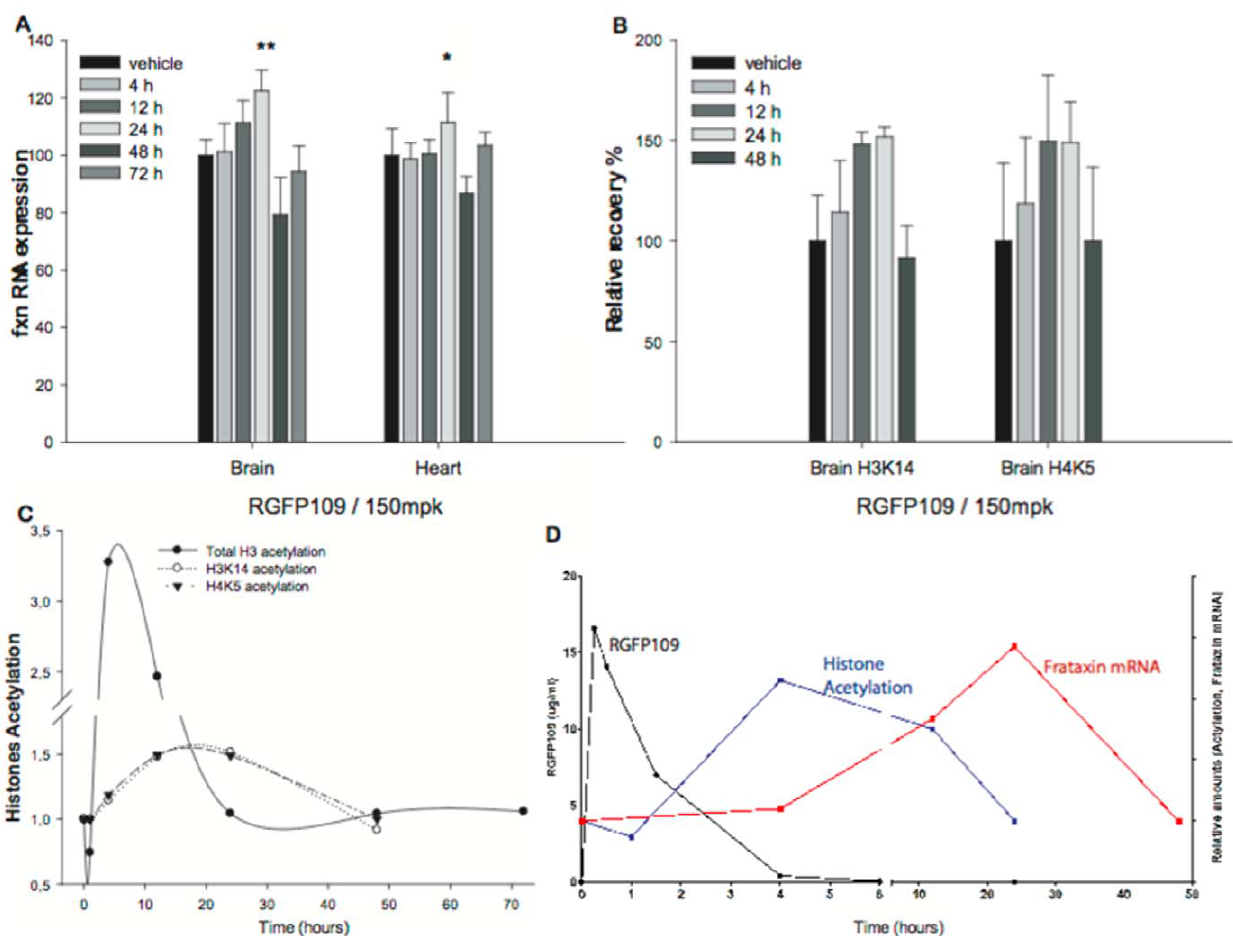
Figure 4. Time course for drug exposure, frataxin mRNA expression, and histone acetylation changes in the brain and heart of KIKI mice. A. Fxn mRNA measurement by quantitative real-time RT-PCR in brain and heart of KIKI mice dosed subcutaneously with 109 at 150 mg/kg (n=26) or vehicle (n=13). Treated mice were sacrificed at one of the mentioned time points: 4, 12, 24, 48 or 72 h. Vehicle treated mice were sacrificed 24 hours after injection. Fxn mRNA levels were relative to RER1 and beta-2 microglobulin (b2M). The Fxn level in vehicle injected KIKI of each tissue was set to 100. All quantifications were done in triplicate and bars indicate s.d. (** p , 0.001; * p , 0.05). B. Levels of H4K5 and H3K14 acetylation in KIKI mice brain treated with one subcutaneous injection of 150 mg/kg of 109 compared to vehicle-treated KIKI littermates, after 4, 12, 24 or 48 hours (n=4 for each shown time point). We performed ChIP experiments with antibodies for murine histones H3 and H4 carrying each modification. Primer pairs corresponded to the first intron of the mouse frataxin gene just upstream of the point of insertion of the GAA repeat in KIKI mice. Relative recovery, determined as previously (Fig. 3B) is set to 100 for each residue. Each immunoprecipitation was quantified in triplicate. Error bars are s.e.m. C. Brains from wild-type mice for total histone H3 acetylation and from KIKI mice for specific residues acetylation, injected with either vehicle or with 150 mg/kg of 109 , were harvested after a period of 1, 4, 12, 24, 48 or 72 hours (n=5 per condition) and subjected to western blot with total or acetylated histones H3 antibodies for WT samples or to chromatin immunoprecipitation for KIKI samples. Ratio of acetylated H3 over total H3 is plotted, showing a peak of acetylation at 4 hours. Recovery of specific residues is plotted, showing a plateau between 12 and 24 hours. D. Composite graphic of 109 measures in mouse brain: in black, drug 109 exposure measured in m g/ml; in blue, total histone acetylation from western blot quantification (panel C); in red, fxn RNA as determined by qPCR in panel